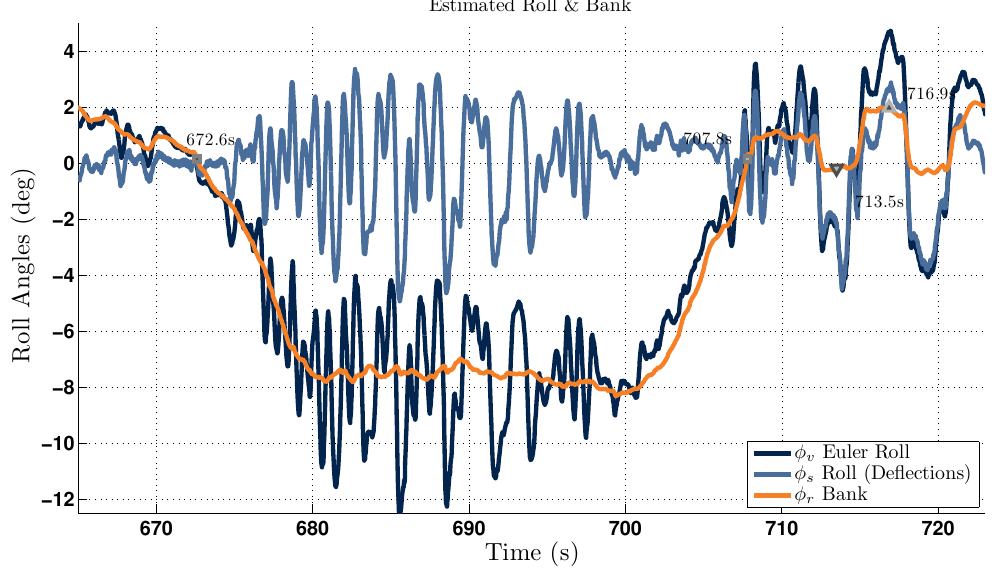
Figure 19. Coupled EKF on the NCAT oval track roll excitation bank